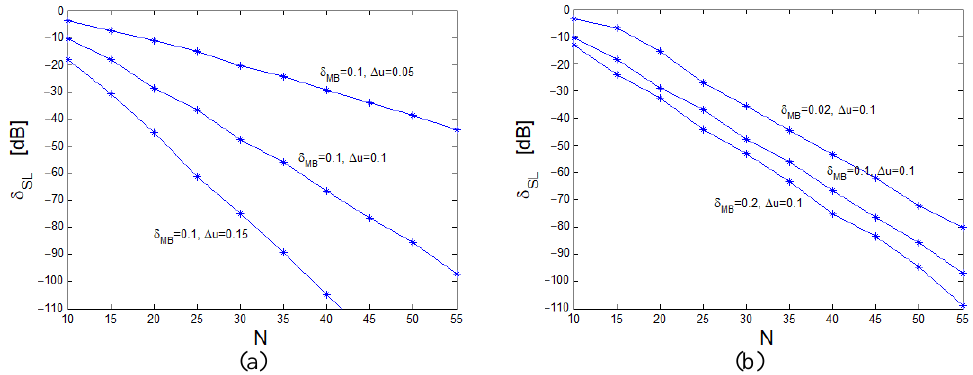
Figure 3. Maximum side lobe level 𝛿 𝑆𝐿 (in dB) as a function of 𝑁 , obtained with 𝑢 𝑀𝐵 = 0.375 and: ( a ) a common value of 𝛿 𝑀𝐵 = 0.1 and varying Δ𝑢 ; ( b ) a common value of Δ𝑢 = 0.1 and varying 𝛿 𝑀𝐵 .